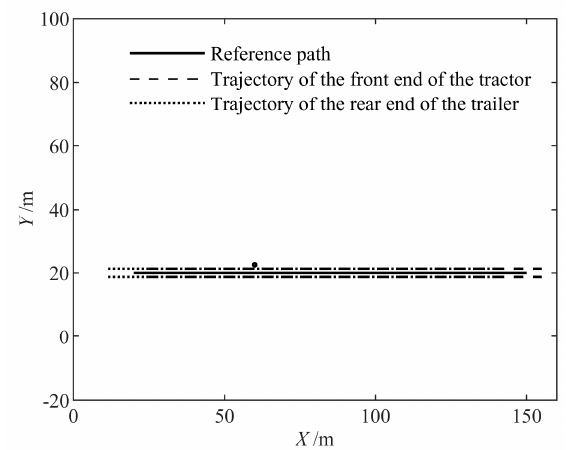
Figure 7. The trajectory of the obstacle avoidance controller based on the line model in the first group of simulations.